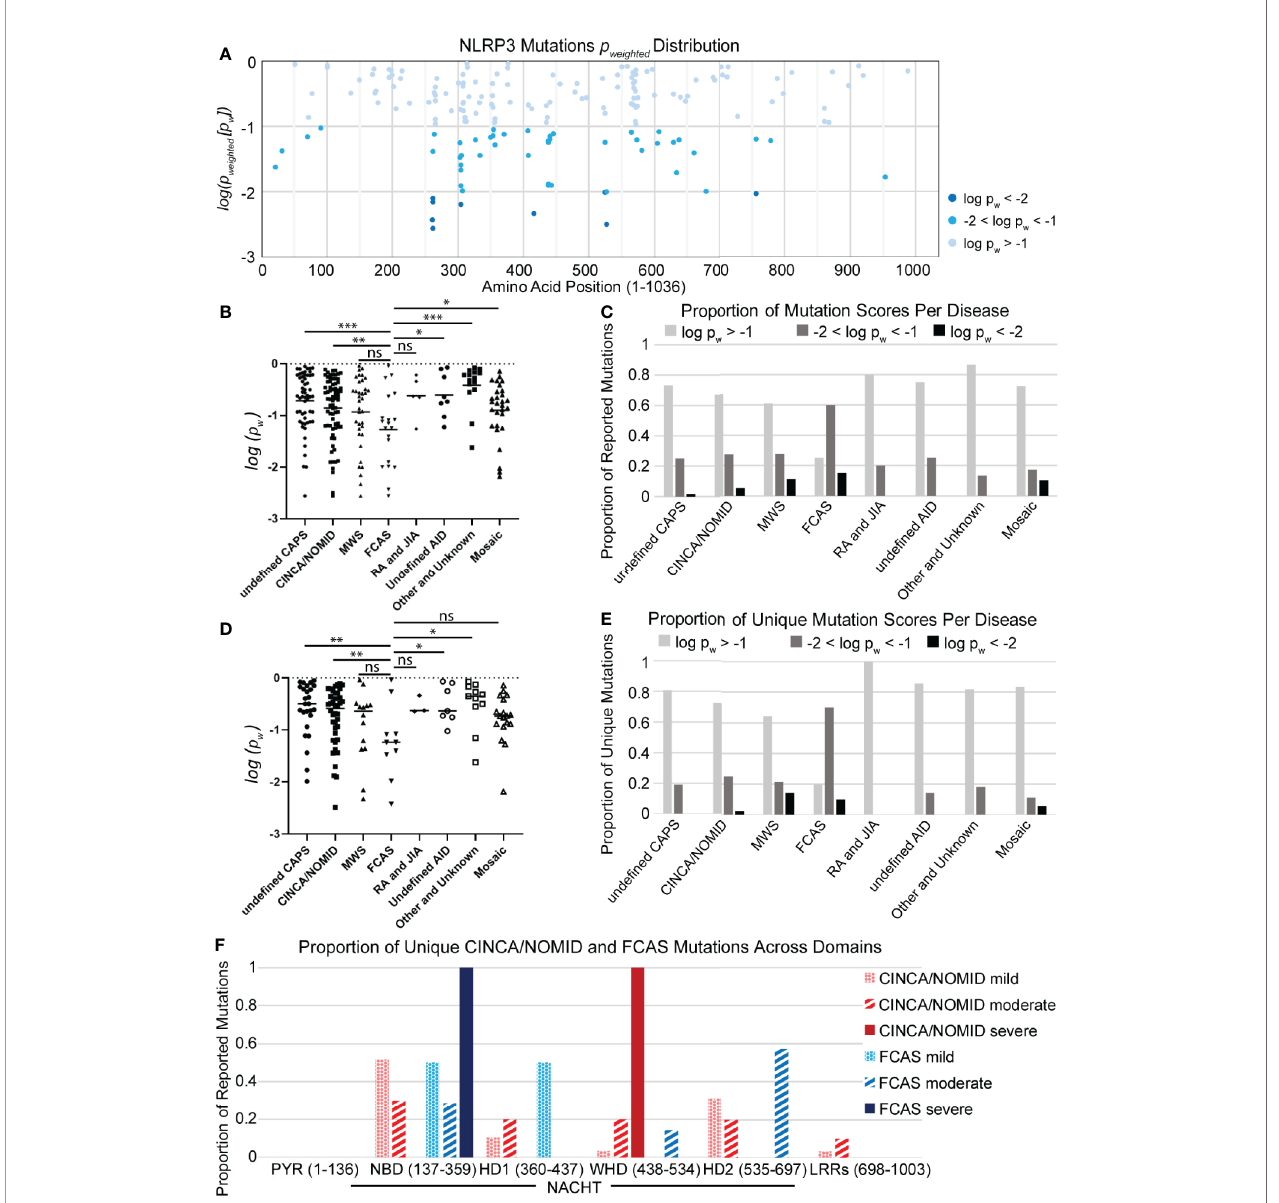
FIGURE 2 | (A) Distribution of NLRP3 mutation pw scores across amino acid positions. (B) Disease-speci fi c mutations scores. Statistical signi fi cance was determined against FCAS by t-test. (C) The proportion of reported mutations for NLRP3 -AID and other NLRP3 -mutant conditions per p w score. (D) Non-overlapping disease-speci fi c mutation scores. (E) The proportion of unique mutations for NLRP3 -AID and NLRP3 -mutant conditions per pw score. (F) The proportion of unique CINCA/NOMID and FCAS mutations across the NLRP3 domains per clinical severity (mild – dotted; moderate – striped; severe – solid). Statistical signi fi cance was determined against FCAS by t-test. ns, not signi fi cant; *p < 0.5, **p < 0.01, ***p <